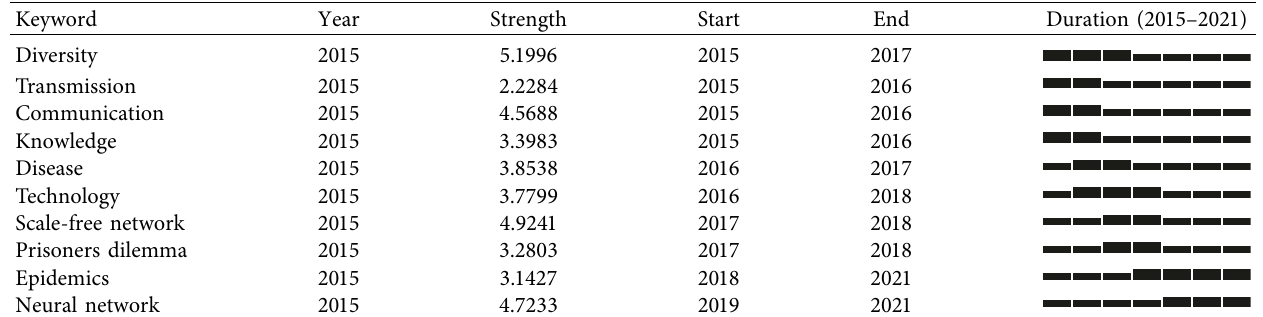
Table 6: Top 10 keywords with strongest citation